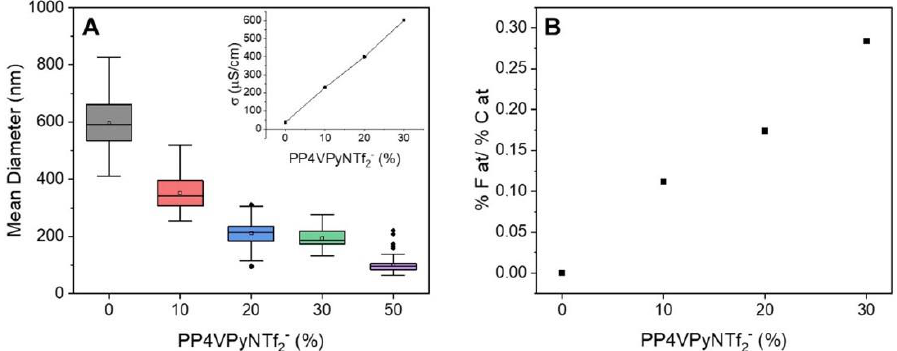
Figure 3. ( A ) Diameters Distribution of P4VPy and P4VPy/PP4VPyNTf 2 − nanofibers and corre- sponding solution conductivities (insert). ( B ) EDX analysis of the relative content of fluorine respect to carbon atoms, % F at/% C at.